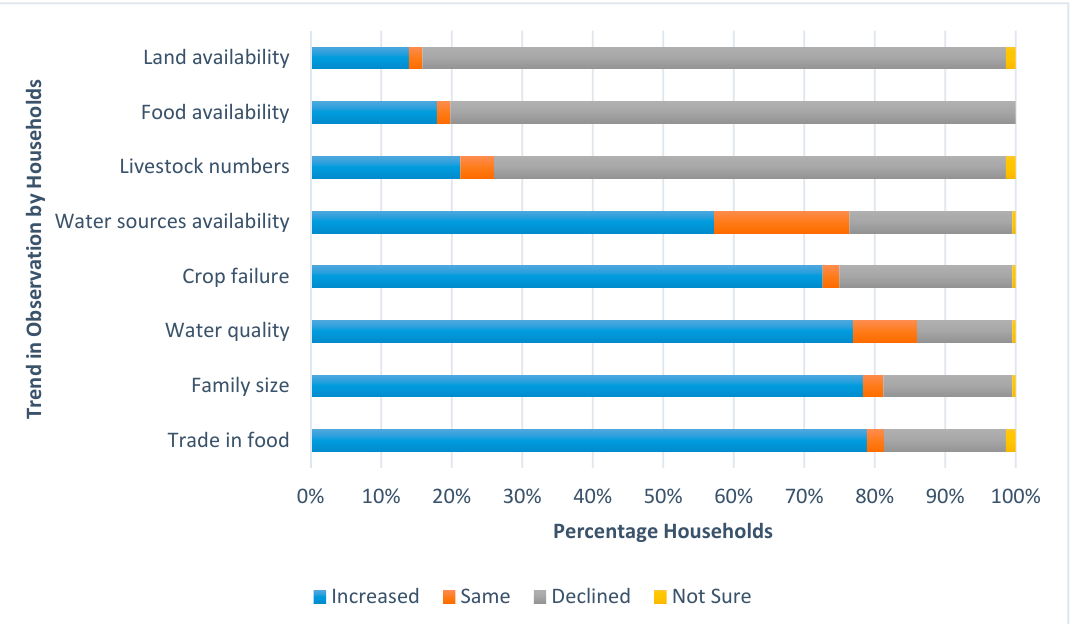
Figure 4. Perceived trends observed in 5–10 years prior to the study year in relation to food production and availability in the commercial sugarcane cultivation areas of Mayuge and Jinja Districts, Eastern Uganda .